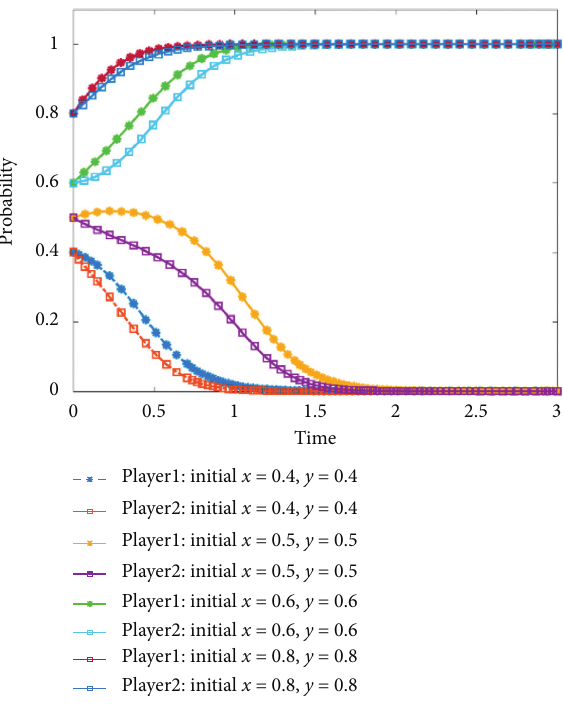
Figure 12: Evolutionary game phase diagram of the system for different initial